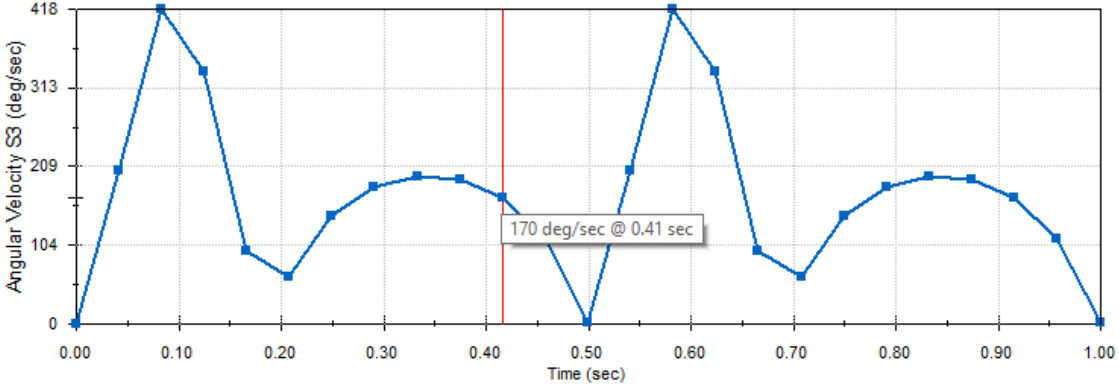
Figure 12. O B crank center of mass (S 2